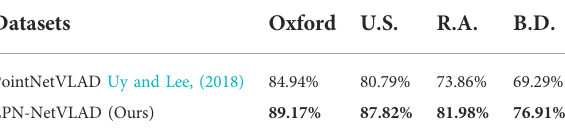
Bold values in tables show the best